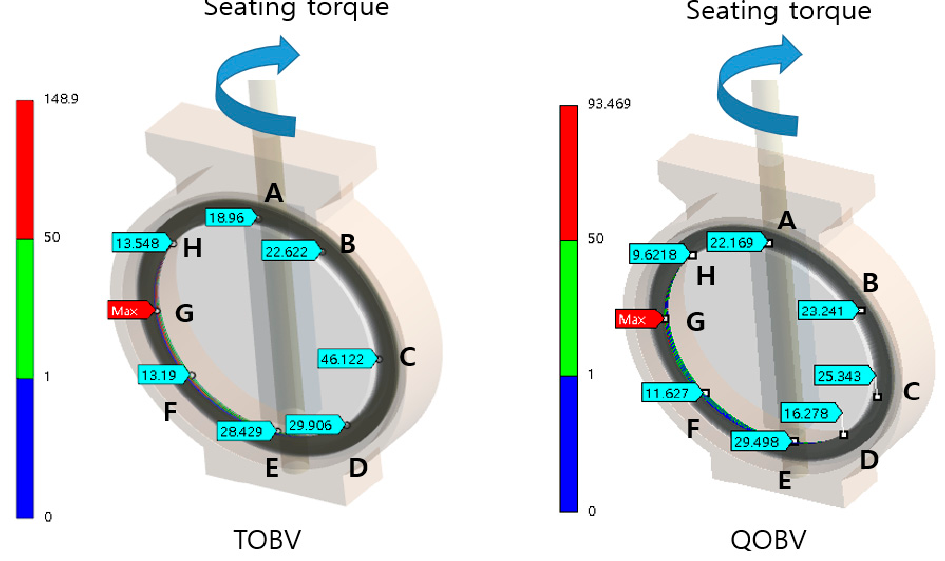
Figure 19. The contact pressure distributions of TOBV and QOBV. Table 4. Comparison of the contact pressure of TOBV with that of QOBV. TOBV QOBV A 18.960